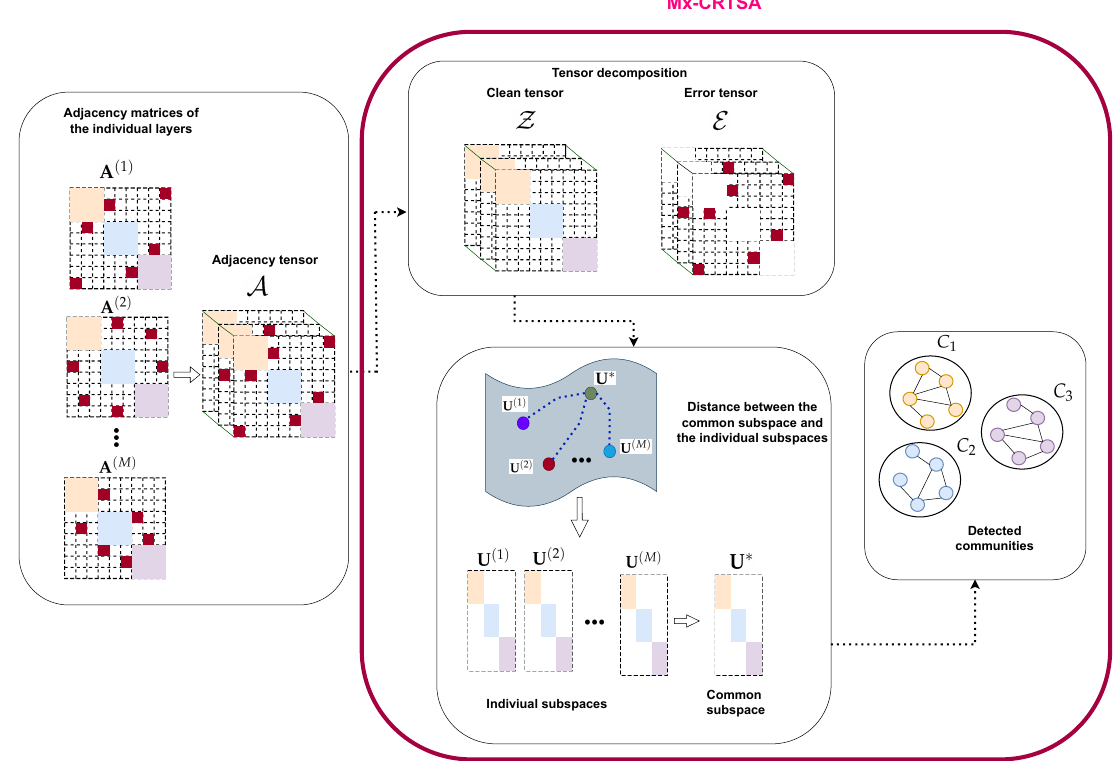
Figure 1. A flowchart of the proposed Mx-CRTSA